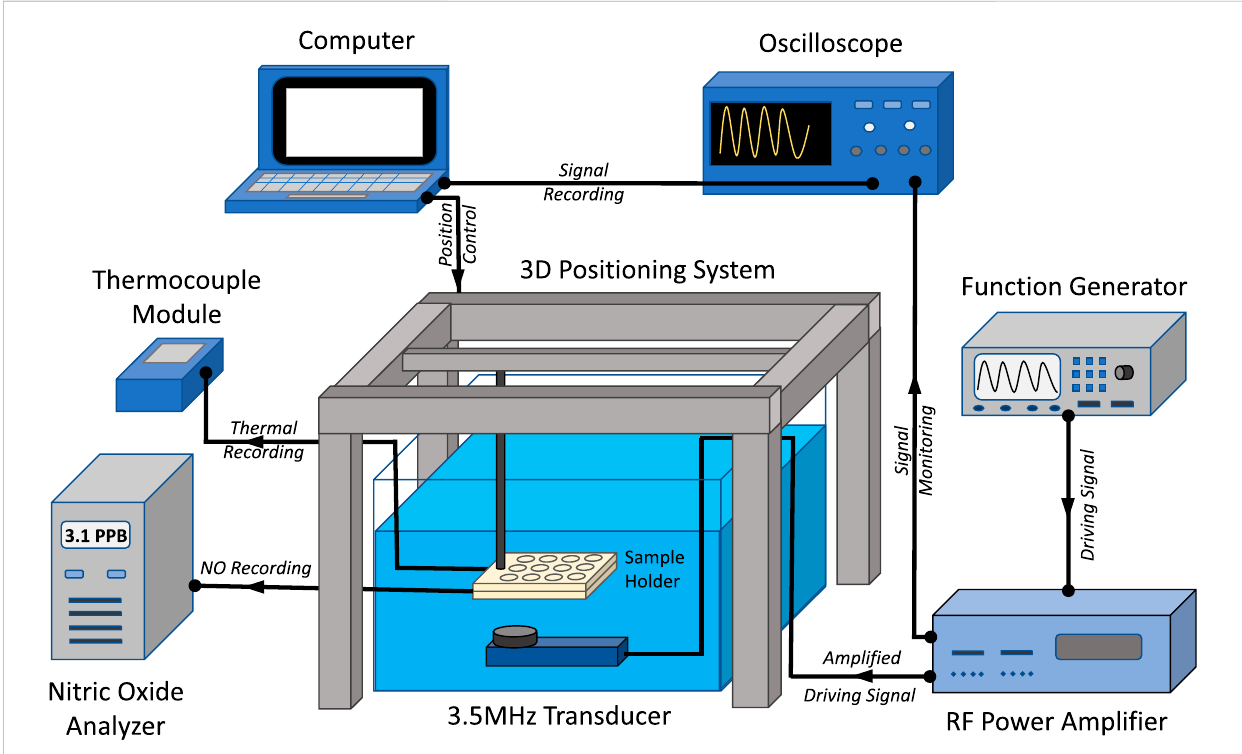
FIGURE 2 Schematicshowingexperimentalset-upofFUSsystem.Thetransducerwasdrivenbyafunctiongeneratorandradiofrequency(RF)powerampli fi er. Driving signals were monitored with an oscilloscope and a 3D positioning system was used to align the FUS transducer focal region in sample holders. Thermocouples were utilized to monitor sample temperature while a nitric oxide analyzer was used to record NO release.